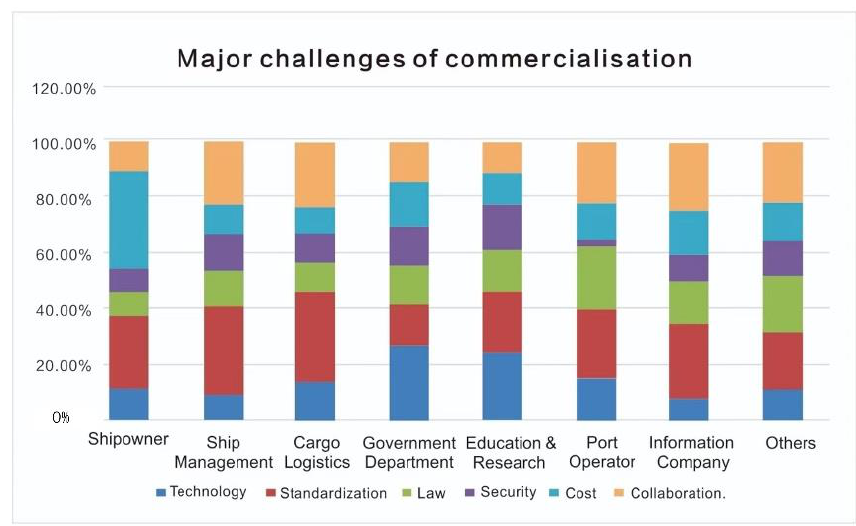
Figure 5. Major challenges of commercialization.